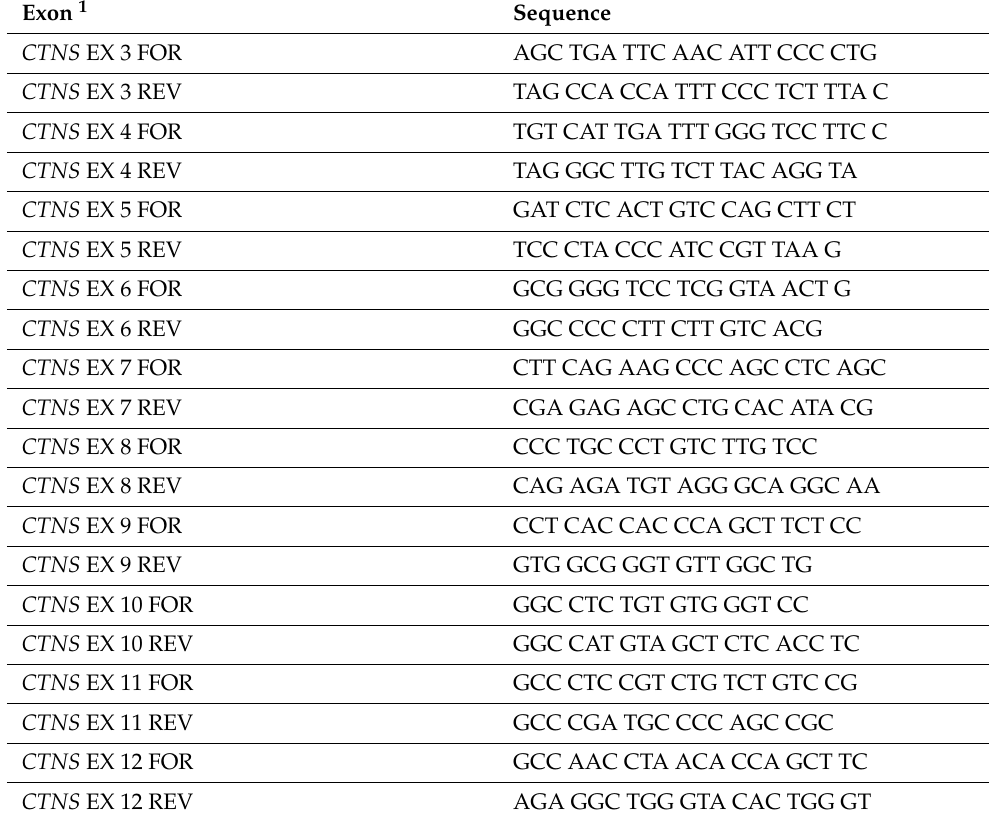
Table 3. Primers used for PCR amplification of the CTNS coding exons and the intron– exon